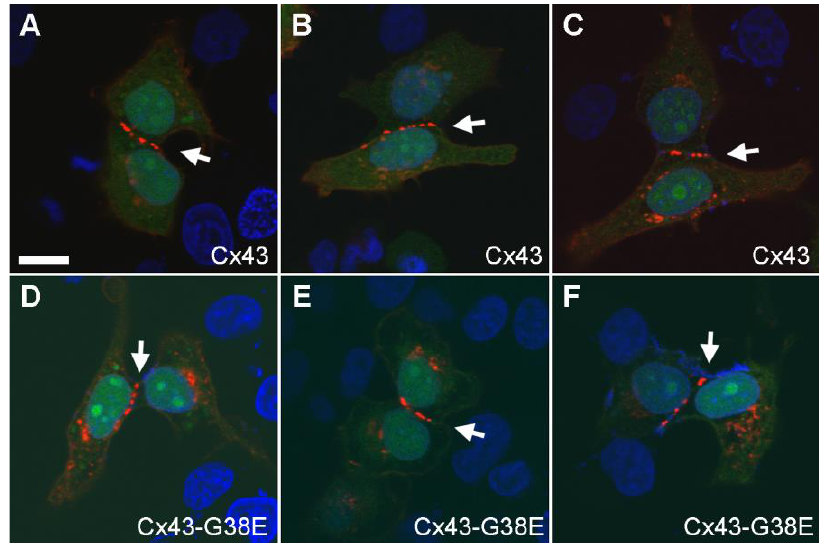
Figure 4. Localization of Cx43-G38E in transfected HeLa cells. ( A – C ) HeLa cells (DAPI stain, blue) transfected with wild-type Cx43 displayed a strong Cx43 antibody labeling (red) that concentrated in linear arrays of plaques at cell-to-cell interfaces (white arrowheads) and correlated with GFP fluorescence (green). ( D – F ) HeLa cells transfected with the Cx43-G38E mutation showed similar punctate Cx43 staining at cellular interfaces. Scale bar = 5 µm.